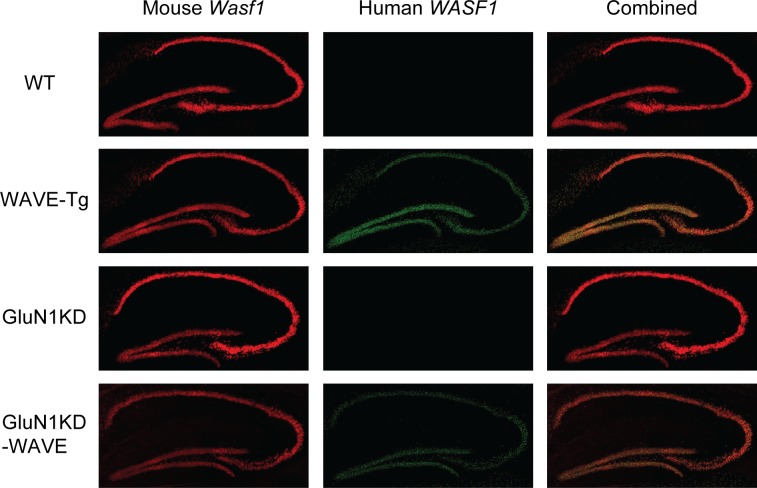
Fluorescent in situ hybridization of male WT, WAVE-Tg, GluN1KD, and GluN1KD-WAVE hippocampus.Endogenous, mouse Wasf1 message is shown in red (left column) while transgenic, human WASF1 is shown in green (middle column). Human WASF1 was expressed abundantly and specifically in transgenic mice with a pattern of expression similar to mouse Wasf1.